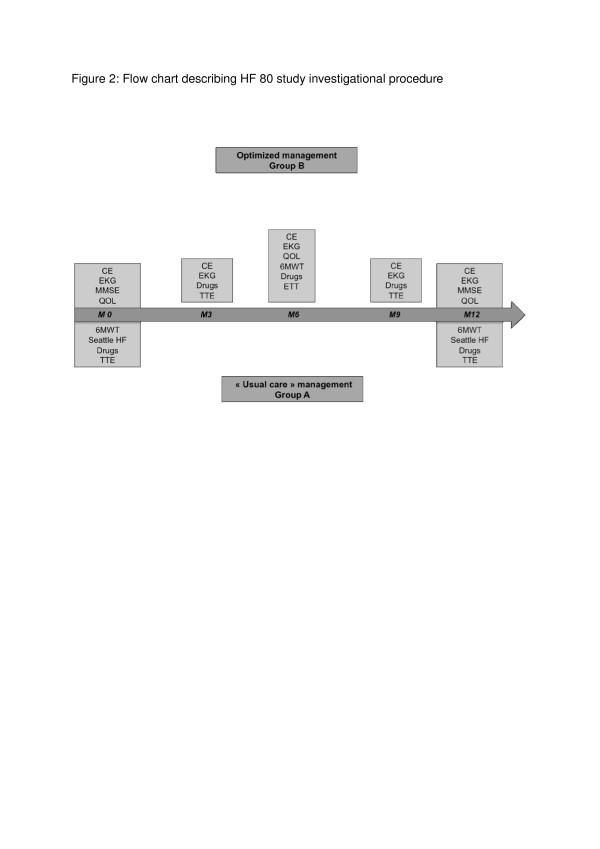
Flow chart describing HF 80 study investigational procedure. CE: clinical examination; EKG: electrocardiogram; MMSE: mini mental state examination; QOL: quality of life scale; 6MWT: 6 minutes walking test; Seattle HF: Seattle heart failure score; TTE: transthoracic echocardiography.